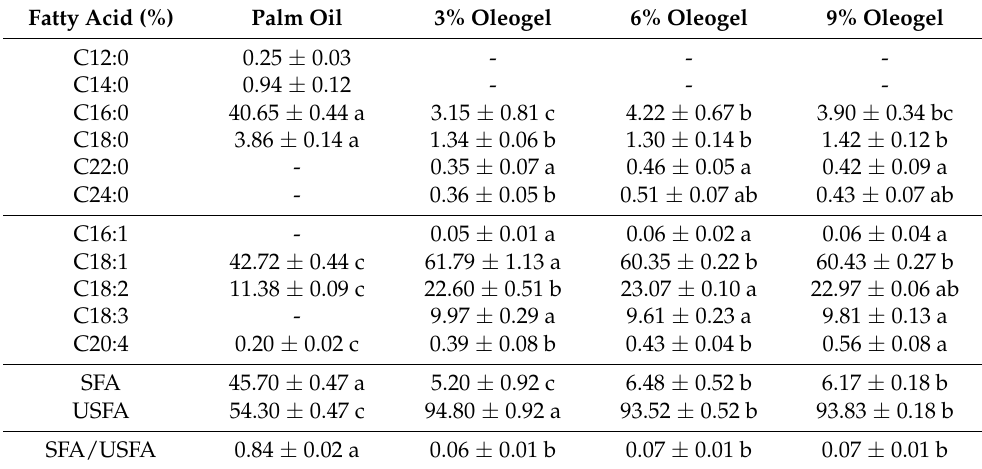
Table 5. Effect of palm oil replacement with oleogels on the fatty acid composition of imita- tion